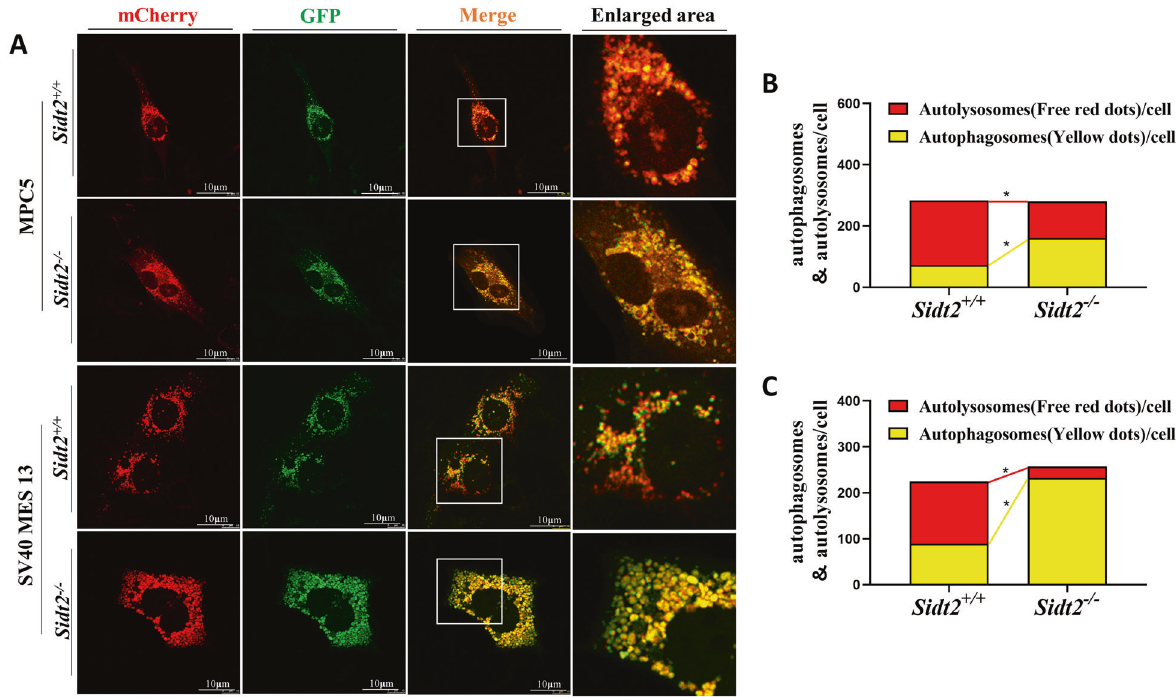
Fig. 6 Autophagy lysosomal degradation pathway is blocked after Sidt2 deletion. A Ad-mCherry-GFP-LC3B application to detect autophagy fl ow in MPC5 and SV40 MES 13 cells before and after Sidt2 knockout; B statistical chart of MPC5 cell autophagosome and autophagolysosome detection results; C statistical chart of SV40 MES 13 cell autophagosome and autophagolysosome detection results. * P <